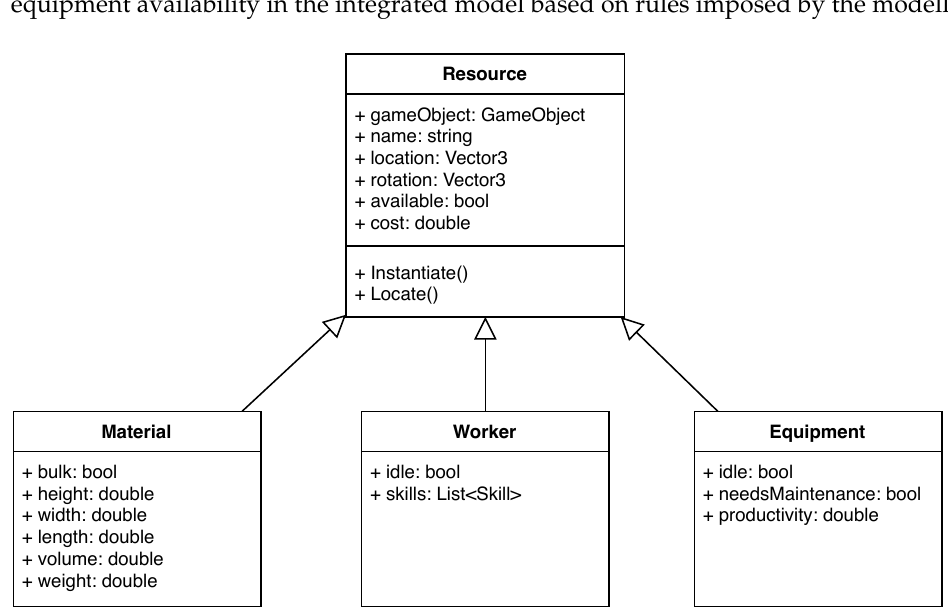
Figure 4. Resource class